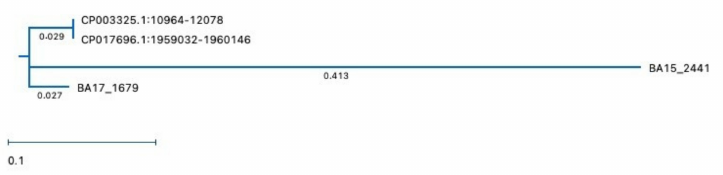
Figure 4. Unrooted phylogenetic tree (constructed by maximum likelihood: RAxML) relating the vanZ of BA15 and BA17 and their distance with the DSM 20089 and PRL2011